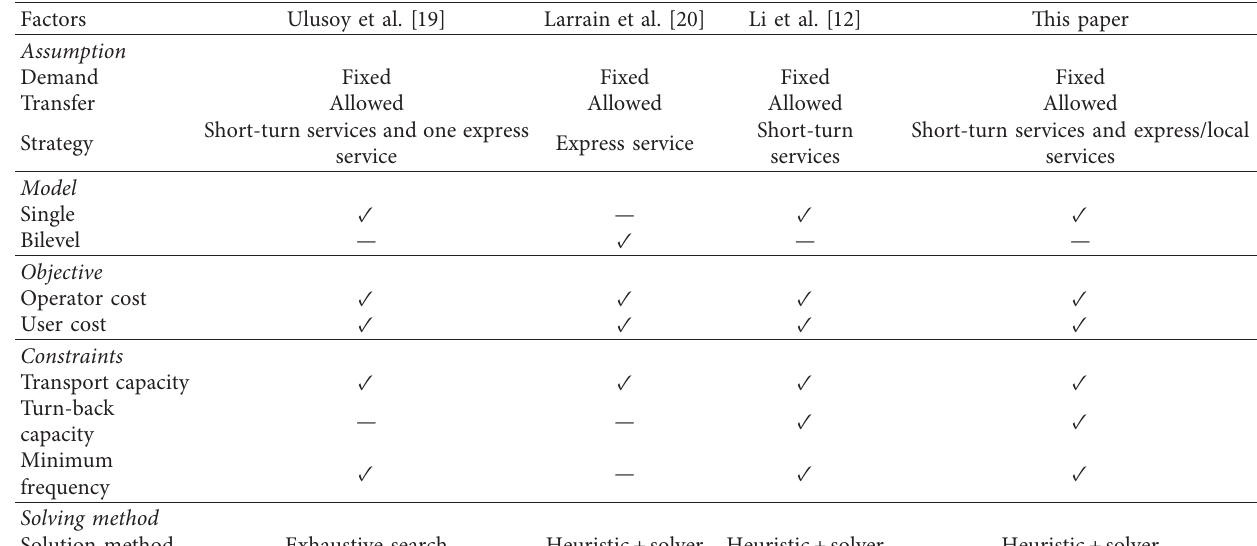
Table 1: Comparisons of this paper with previous